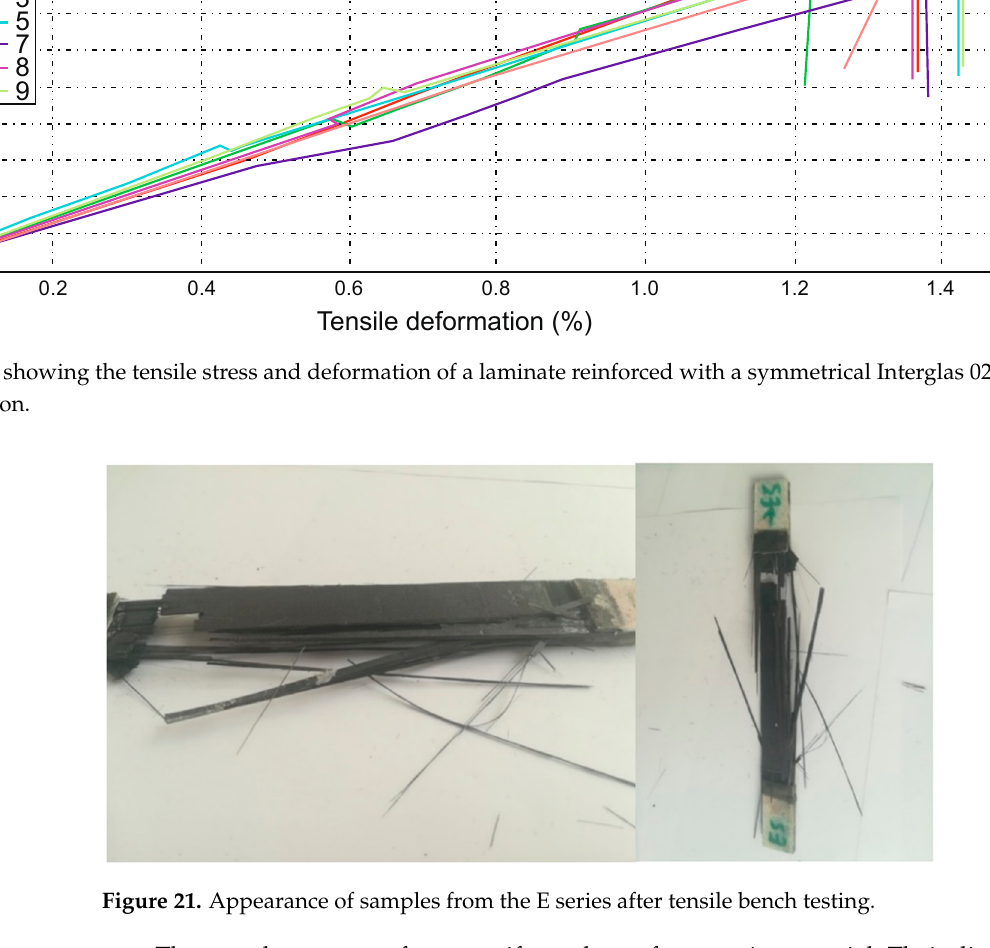
Table 8. Geometric dimensions of composite samples reinforced with the IMS65 modular fabric.